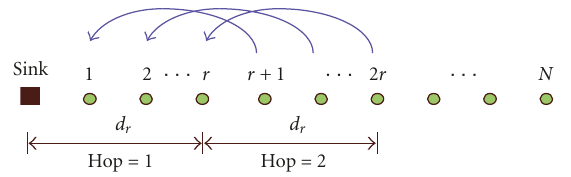
Figure 10: The balanced parent selection